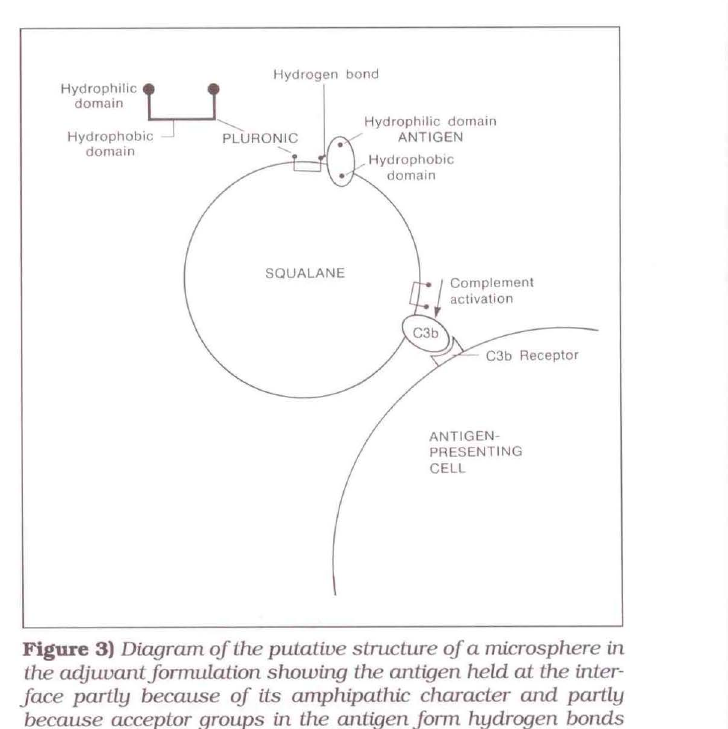
Figure 3} Diagram of ihe putative sinLcture of a microsphere in the adjuvaniformulation showing ihe antigen held at the inter face partly because of its amphipathic character and partly because acceptor groups in the antigenform hydrogen bonds with the pluronic polymer. The pluronic polymer also activates complement by the alternative pathway and C3b formed is retained at the surface of the microspheres, facilitating their binding to C3b receptors on antigen-presenting